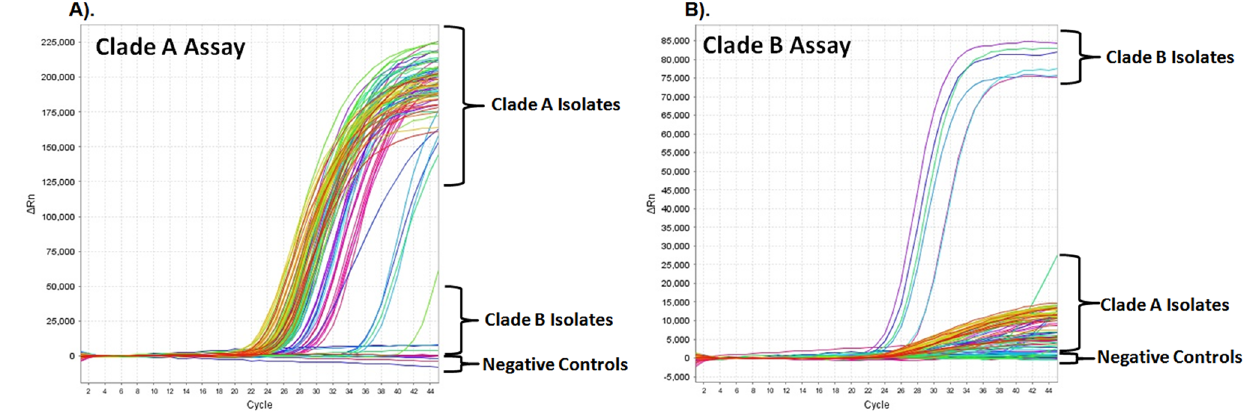
Figure 3. Real-time PCR amplification plots. Real-time PCR amplification plots of Colletotrichum cereale probes used to screen a 96-well plate of C. cereale infected samples. Negative controls are labeled. Positive controls are included within samples diagnosed as belonging to clade A or B. (a). C. cereale clade A probe A-Apn2; (b). C. cereale clade B probe B-Apn2.